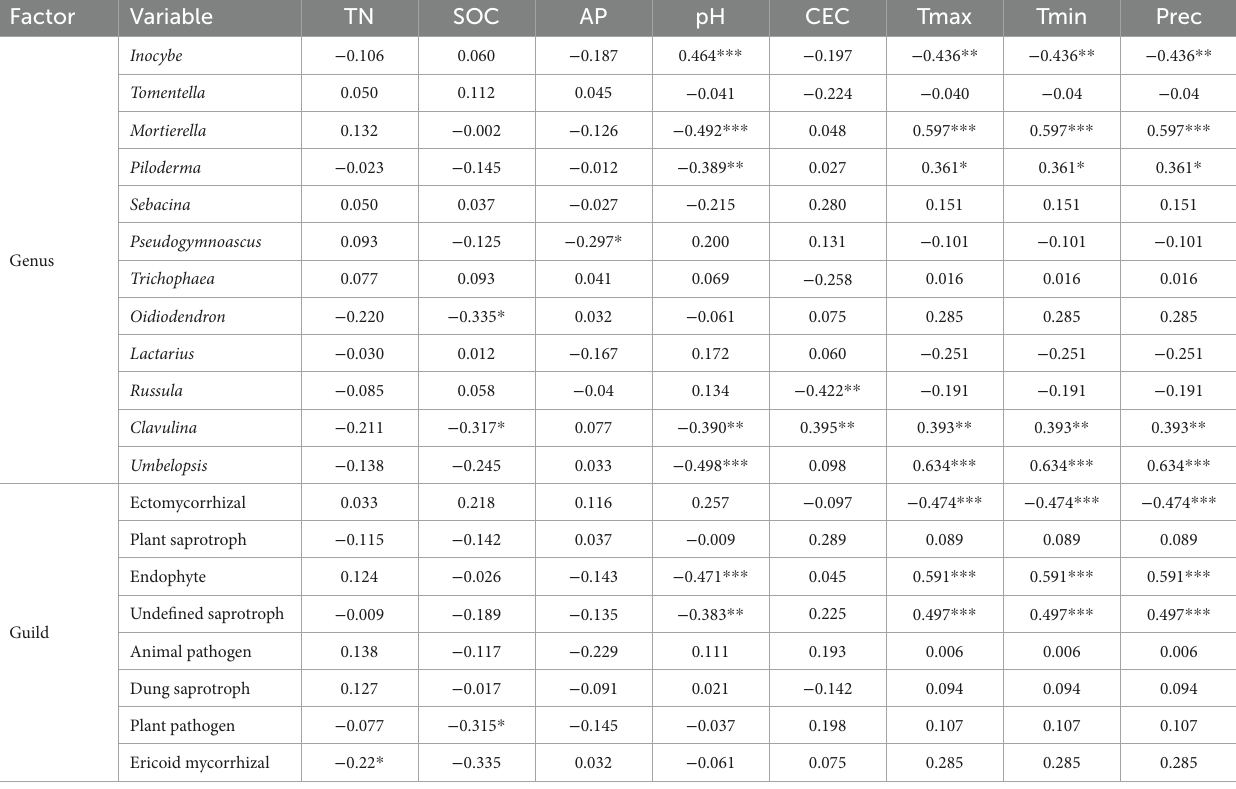
TABLE 3 Spearman correlation coefficients of dominant fungal genera and functional guilds to soil properties. Factor